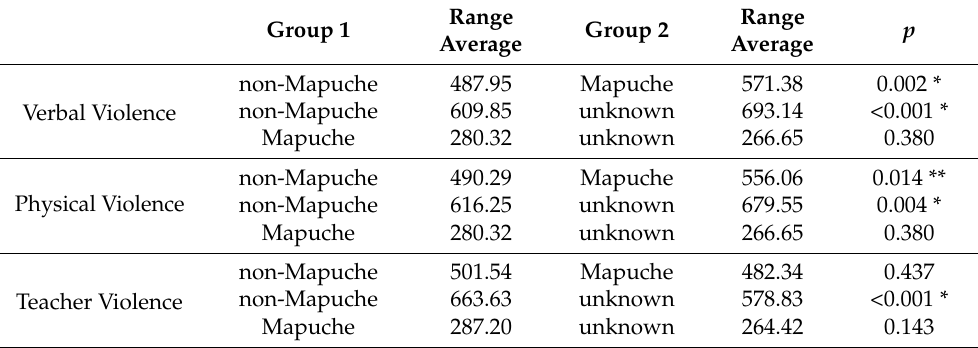
Teacher Violence